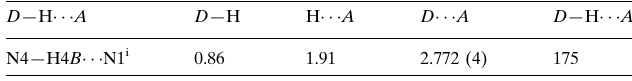
Hydrogen-bond geometry (A˚ , (cid:1)